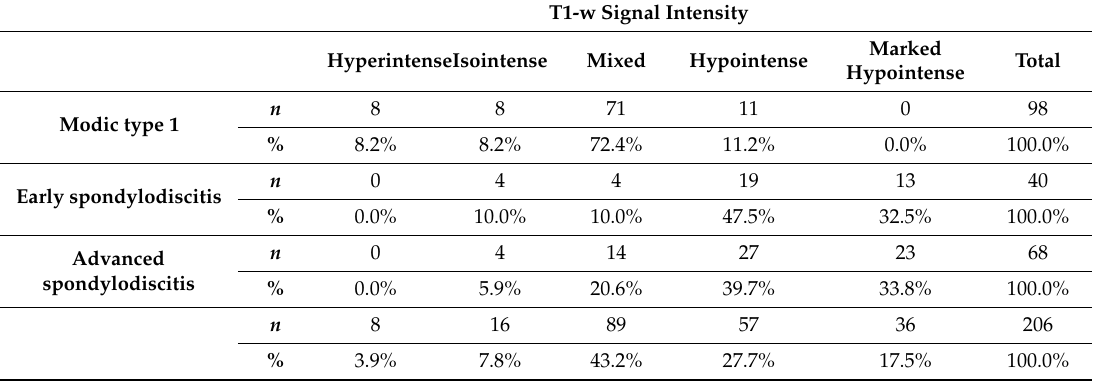
Table 2. Visual assessment of the T1-w signal intensity within the bone marrow edema area, compared to normal, una ff ected vertebral bone